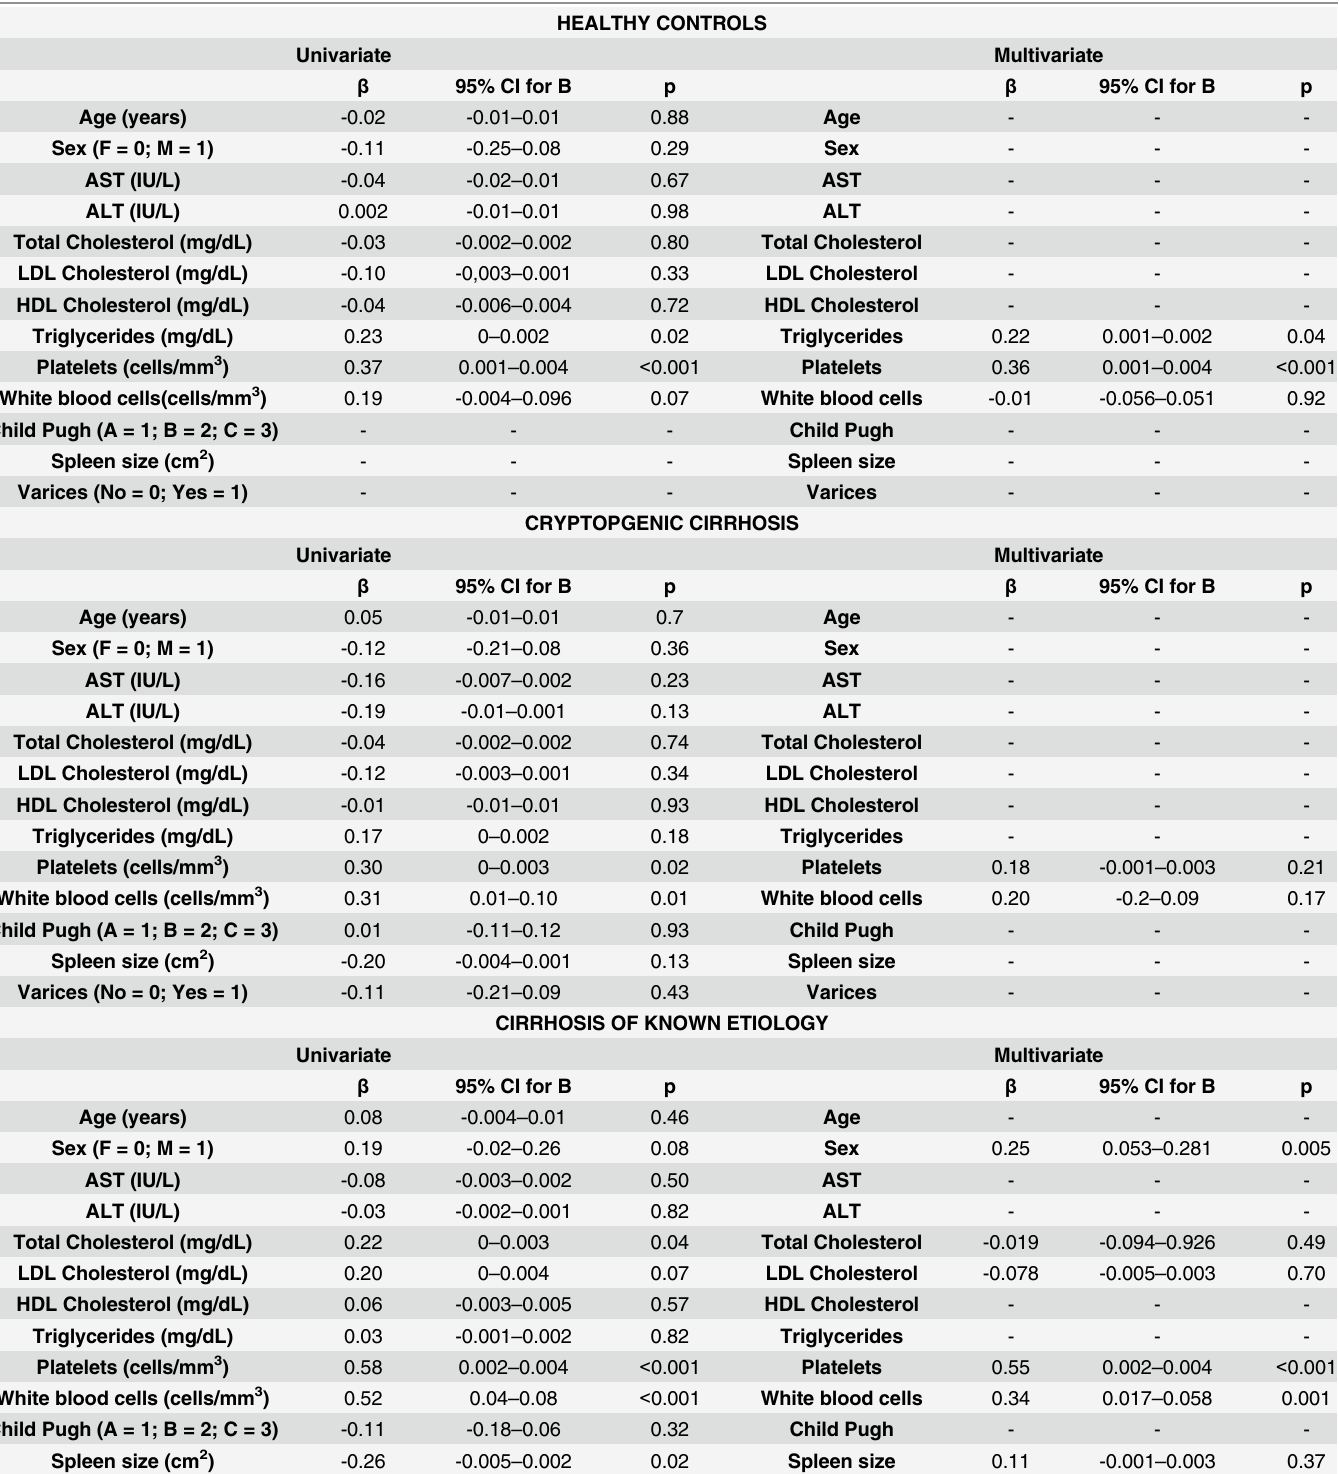
Table 2. Univariate and multivariate linear regression analysis to LAL activity according to the three study subgroups and in the cirrhotic popula- tion as a